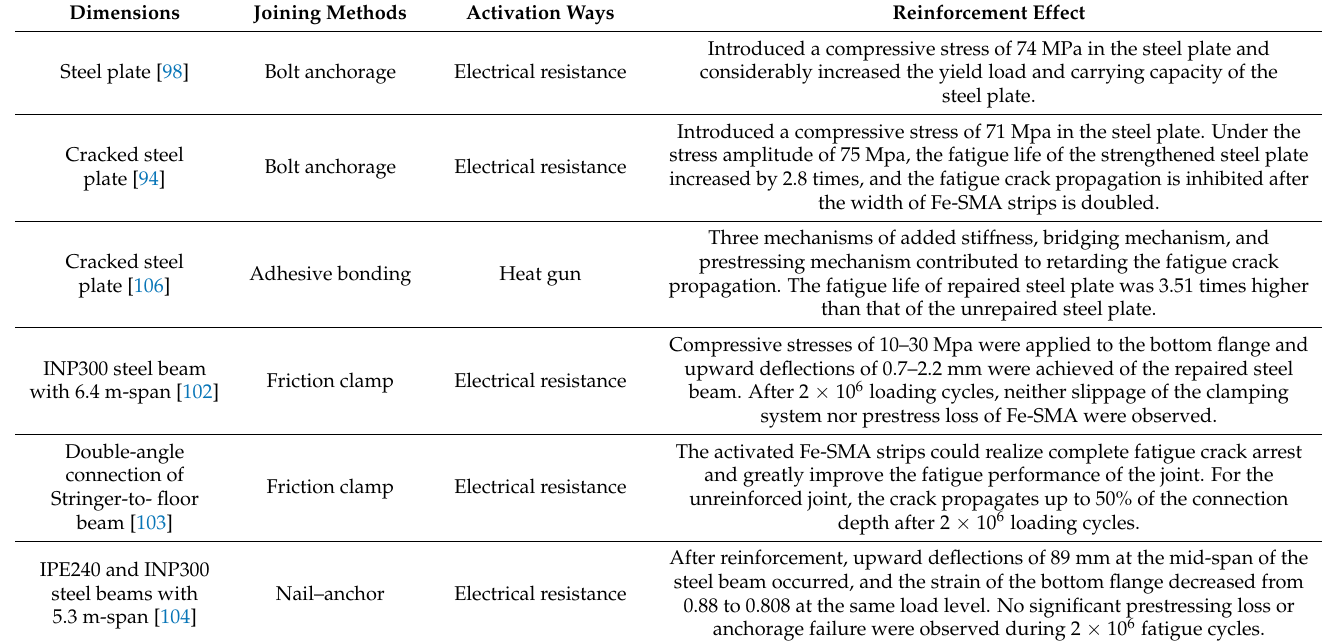
Table 6. Reinforcement applications of steel beams (plates) using